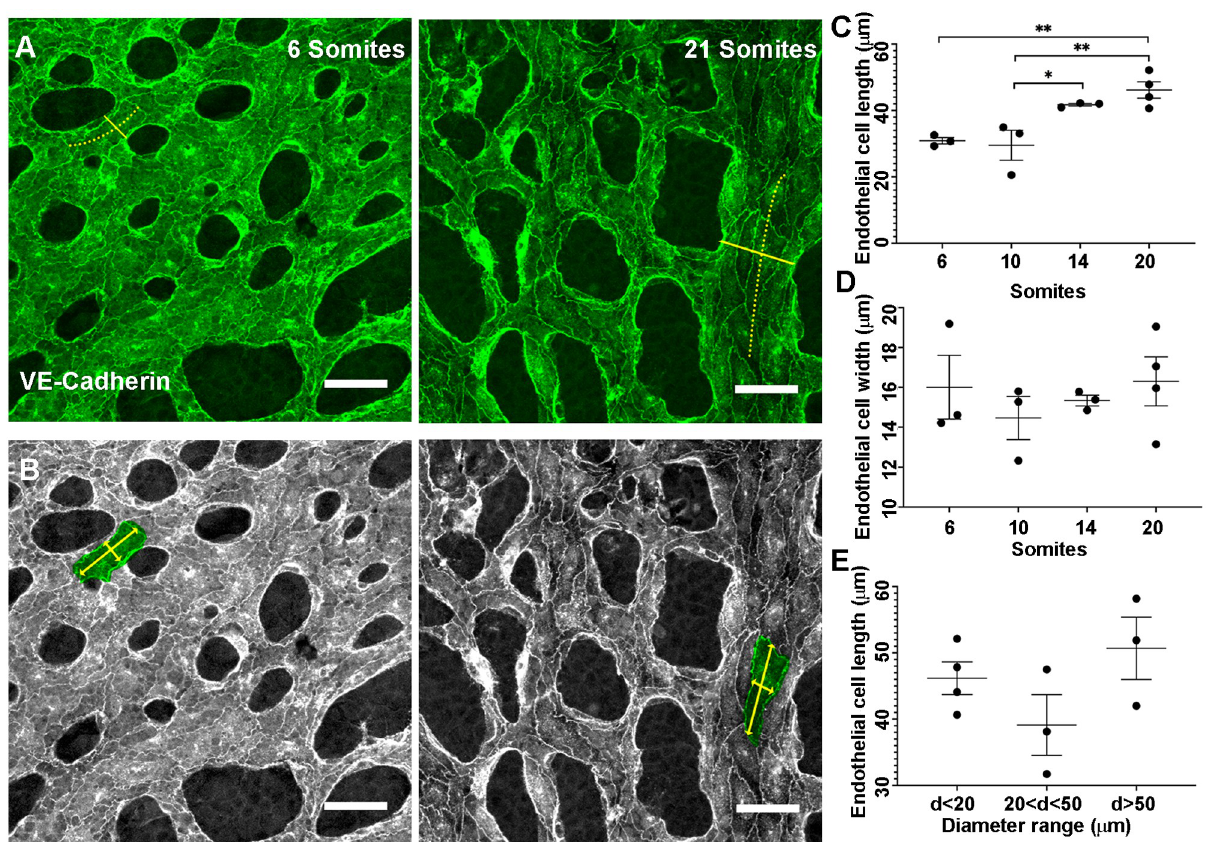
Fig 4. Change in cell shape and density during early stages of development. A) VE-Cadherin staining of ECs in the yolk sac vasculature of a mouse embryo between 6 and 20 somite stage. Solid yellow line shows the vessel diameter and the dotted yellow line shows the vessel centreline. B) Length and width of the selected ECs shown by yellow arrowed lines whereas green shows an individual EC outline. C) EC length increases between somites 10 and 14. D) No significant change in EC width occurs. E) No difference in the extent of elongation between ECs in vessels with different diameters is present (only data from 20 somites is shown). Each data point represents the average for an embryo (n = 3-4 embryos per stage), with between two and 19 cells per embryo analysed. Values are mean ± SEM. Significance is calculated by one-way ANOVA with Tukey’s test. � P < 0.05, and �� < 0.01. Scale bar = 50 μm